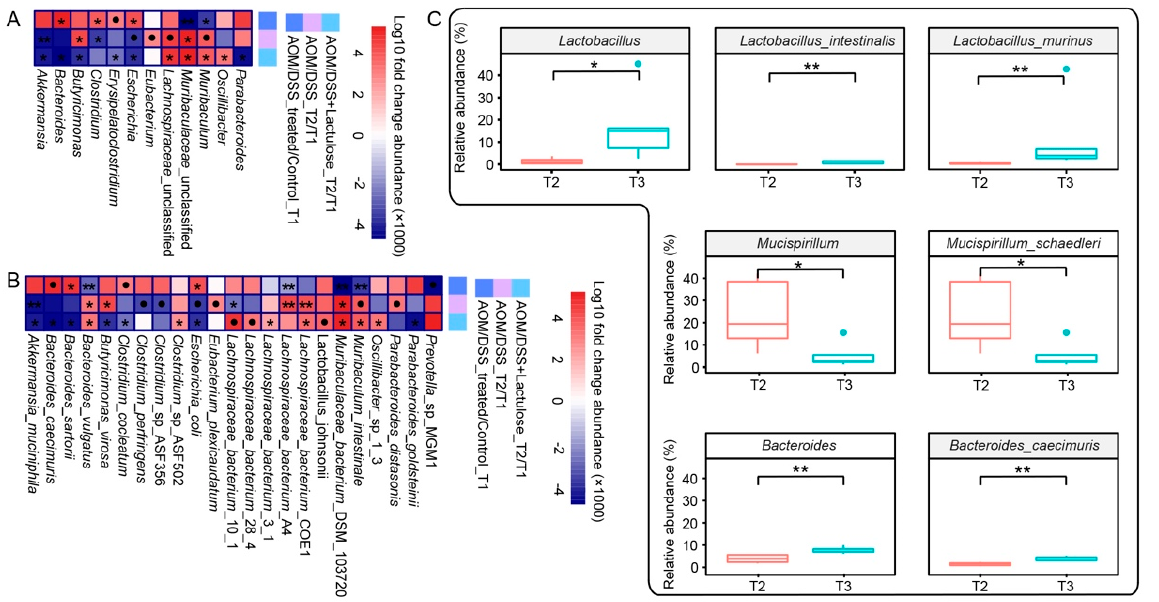
Figure 6. The effect of lactulose on the fecal microbial composition in the AOM/DSS model. ( A,B ) The heatmaps showing fold-change in the abundance of microbiota (genera in A , species in B ) by the comparison indicated in a key: control vs. AOM/DSS at T1, T1 vs. T2 in AOM/DSS and AOM/DSS + lactulose. The differences in microbial composition were calculated by subtraction and significance was calculated using the Wilcoxon test. The values of log10 of the fold change ( × 1000) were scaled as shown in the key. • 0.05 < p < 0.06, * p < 0.05, ** p < 0.01 ( n = 5). ( C ) The relative abundance of the indicated genera and species at T2 and T3 in the AOM/DSS + lactulose group. * p <0.05, ** p < 0.01 ( n =5).